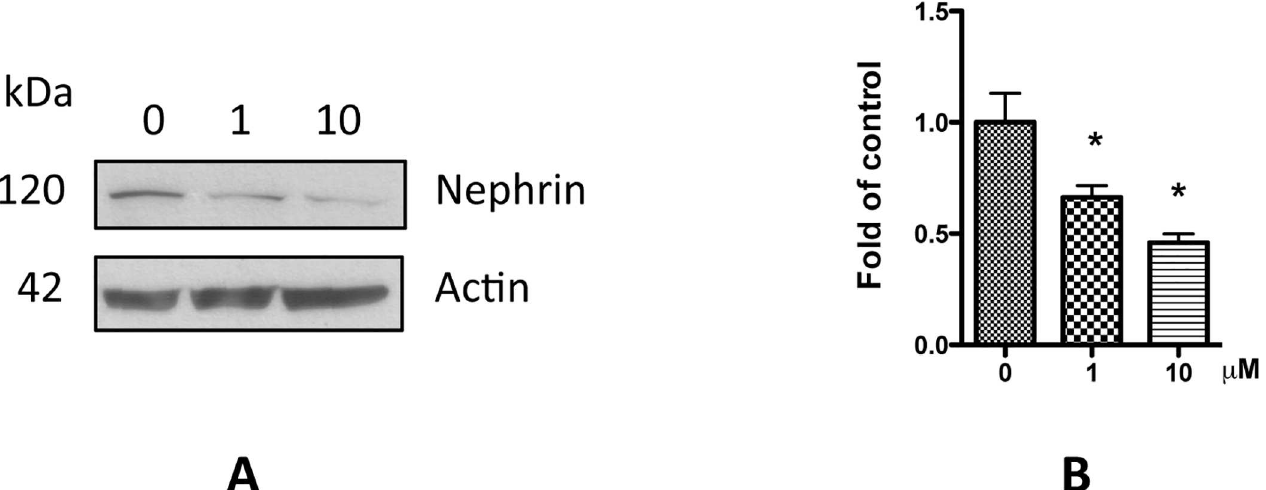
Fig 2. Nicotine decreasenephrin expression in podocyte. Differentiated humanpodocytes were treated with nicotine(1 and10 μ M) for 48 h. Cell lysates were then collectedand subjectedfor Western blotting to detect nephrinexpression. A. Representative gels are displayed. B. Quantification of the expressionof nephrinin A, and the results (mean ± SD) represent three independent samples. * p < 0.05 comparedwith control (0 μ M).